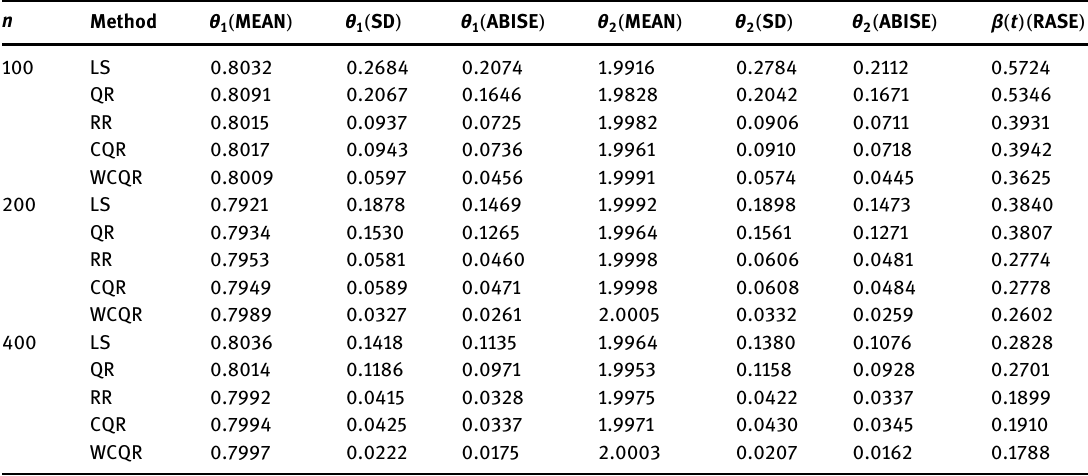
Table 5: Simulation results for θ with LN ( 0, 1 ) random